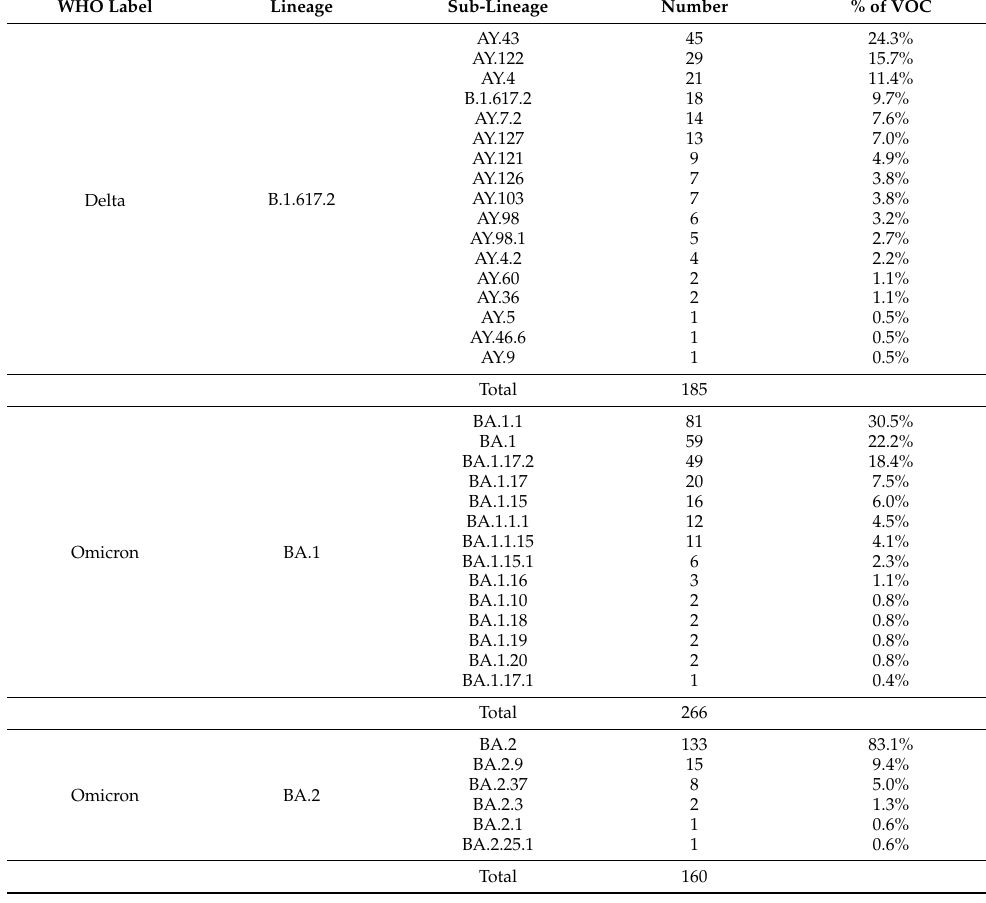
Table 1. Frequency of sub-lineages detected in the study